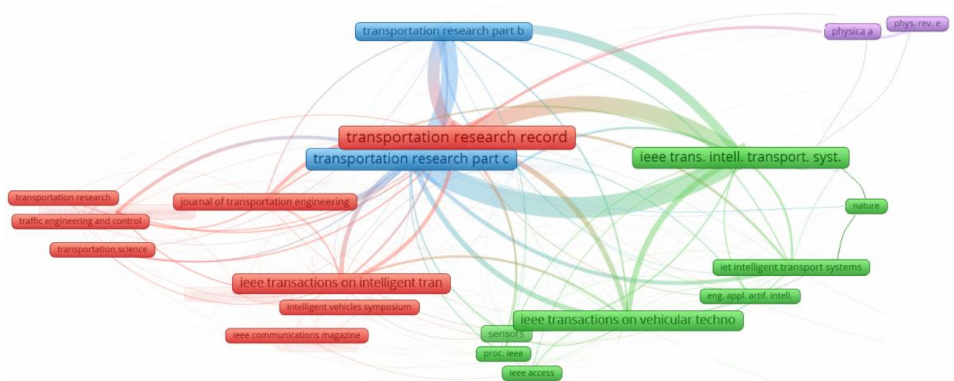
Figure 6. Source visualization of database list “A” obtained by analyzing cocitations. By manually elaborating the resulting data and considering source duplications due to slight differences in the source name, it was possible to elaborate Table 3, where the most influential sources are ordered with regards to the connection strengths evidenced by the network